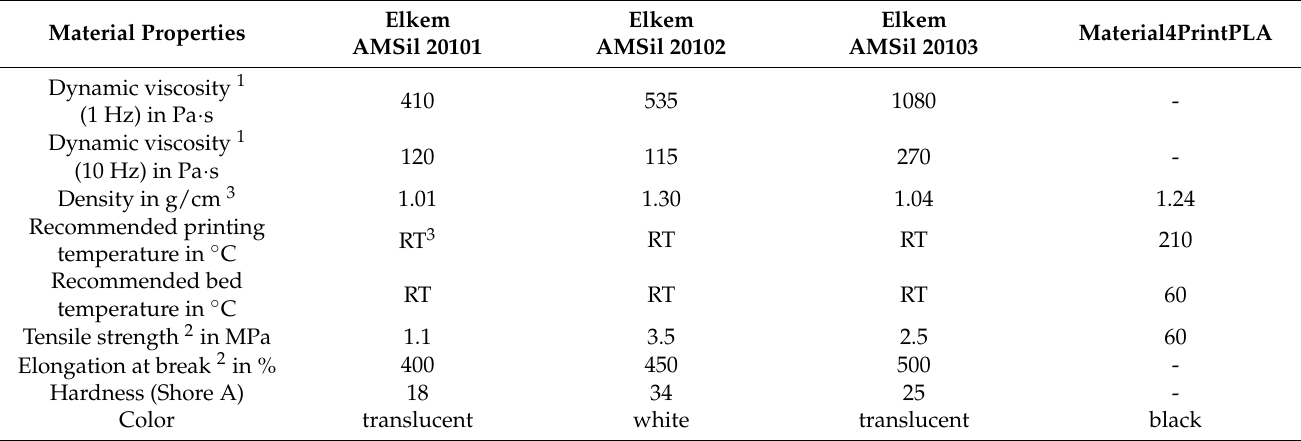
Table 1. The relevant datasheet properties of the printing materials used in this